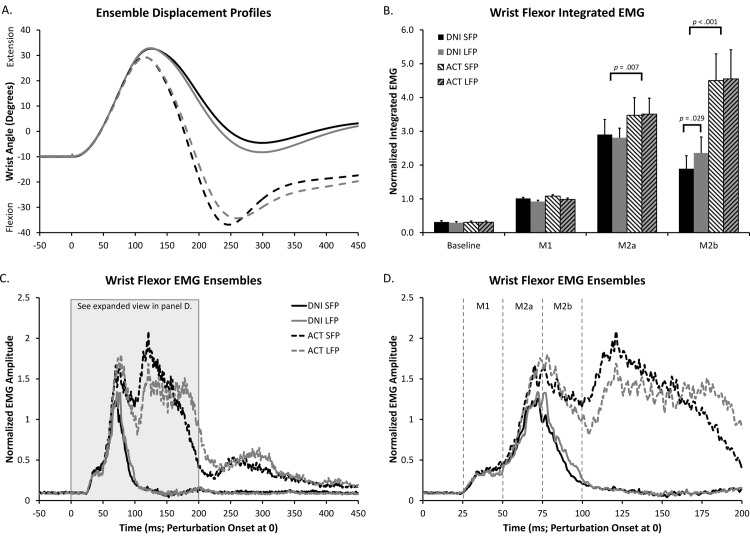
Group (N = 15) displacement and wrist flexor EMG data.A. Ensemble wrist displacement in degrees. B. Normalized integrated wrist flexor EMG values for the epochs of interest. Values were normalized to each participant’s mean integrated EMG activity in the M1 epoch. C. Normalized rectified wrist flexor EMG along same time scale as A. Values were normalized to each participant’s mean peak M1. D. Same as C, but zoomed-in to focus on the time periods of interest.